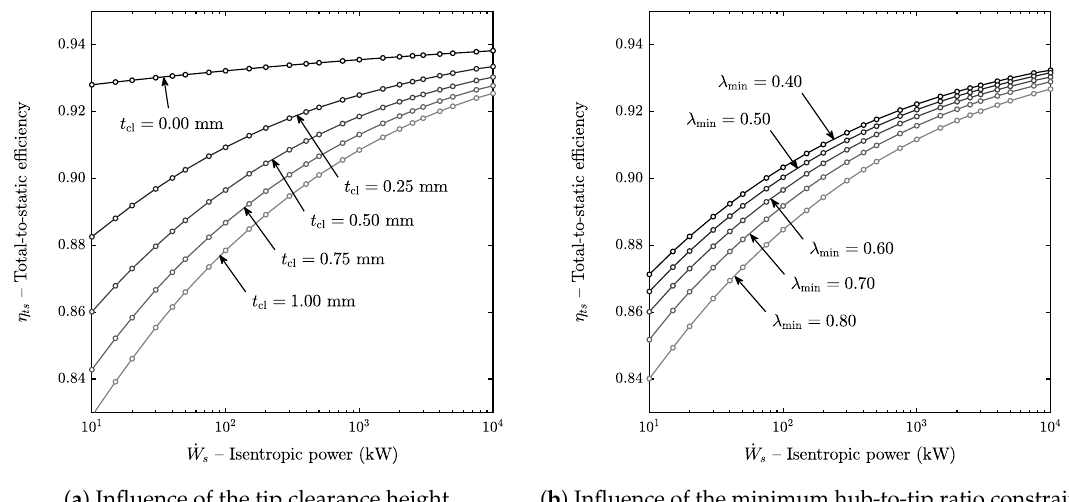
Figure 4. Total-to-static isentropic efficiency as a function of the isentropic power output and ( a ) tip clearance height or ( b ) minimum hub-to-tip ratio